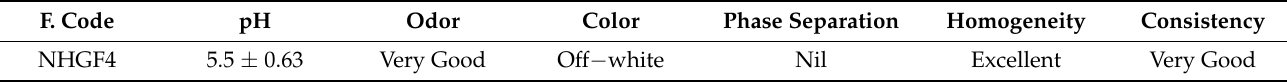
Table 1. Organoleptic analysis of prepared